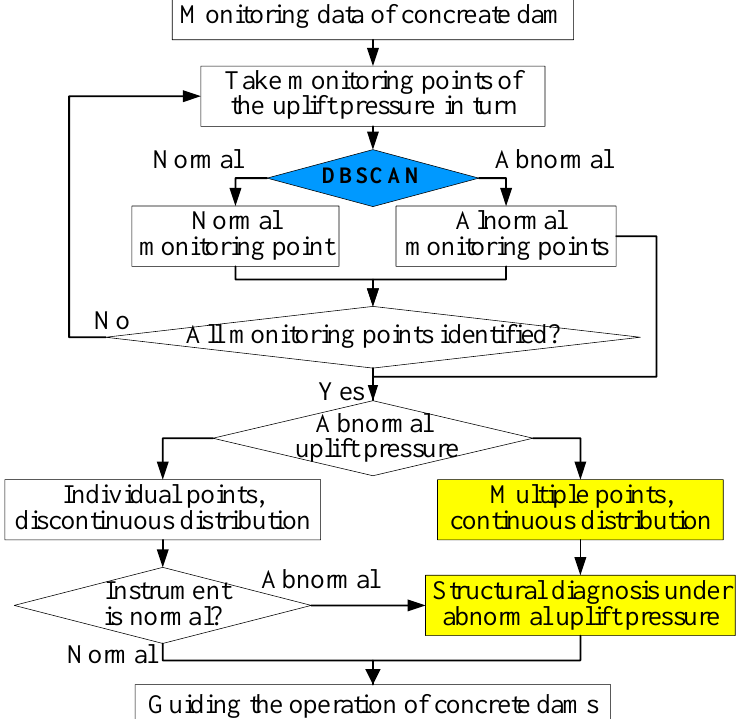
Figure 2. Flow chart of anomaly identification model of uplift pressure, based on DBSCAN.